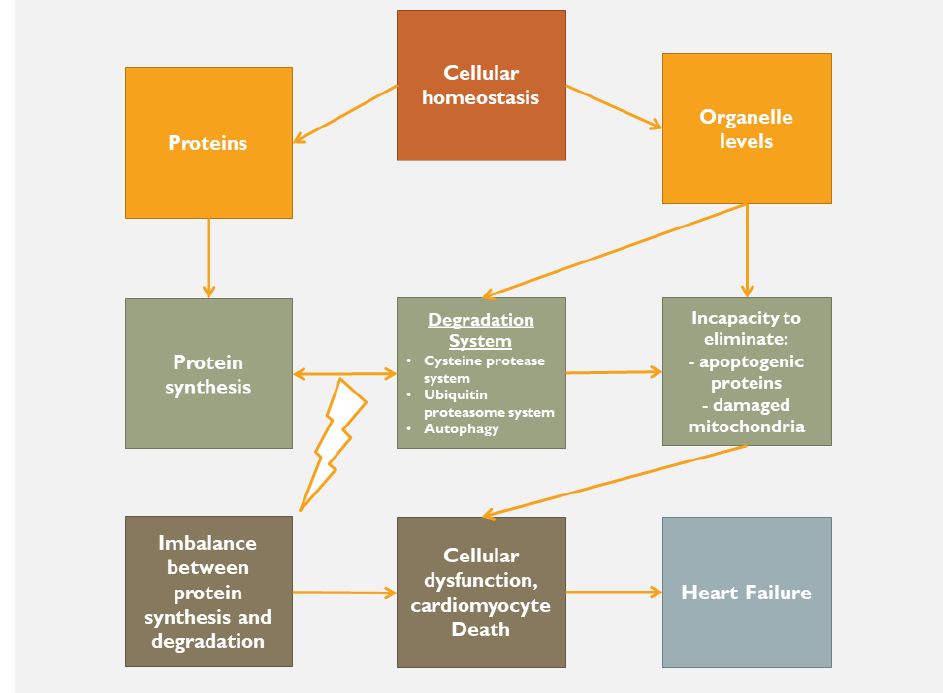
Figure 4. Deranged homeostasis leading to heart failure.